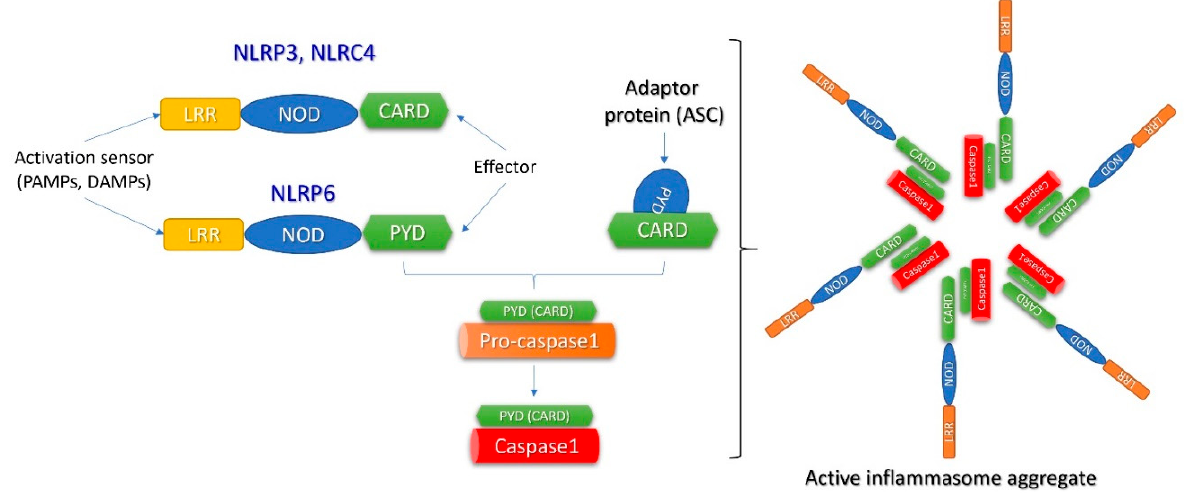
Figure 2. The molecular structure of the inflammasome. This is a large complex multimeric protein consisting of oligomerized NLRP. This consists of a central NOD immune receptor, a leucine-rich repeat (LRR) domain acting as an activation sensor and an effector domain, either a pyrin-containing (PYD) or a caspase activation and recruiting domain—CARD. When activated, the effector domain of NLRP interacts with an adaptor protein (ASC) via a CARD molecule and activates pro-caspase1 into mature caspase1. Pro-caspase1 also has a CARD molecule allowing interaction with the inflamma- some. (Reproduced with permission,